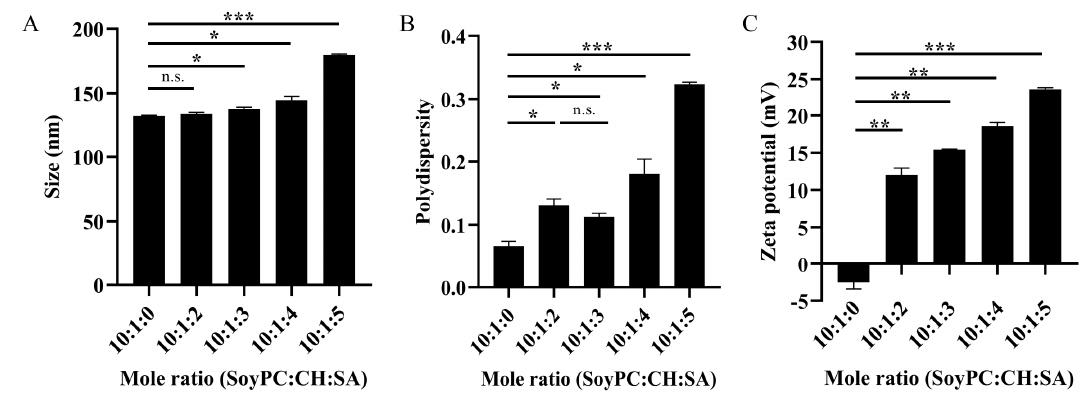
Figure 4. Physicochemical properties of liposomes with various amount of stearylamine (SA) in the liposomes containing soyPC, CH, and SA, including ( A ) particle size, ( B ) polydispersity index, and ( C ) zeta potential. Data are presented as the mean ± SD ( n = 3). n.s. denotes not significant; * p < 0.05; ** p < 0.01; *** p < 0.001.